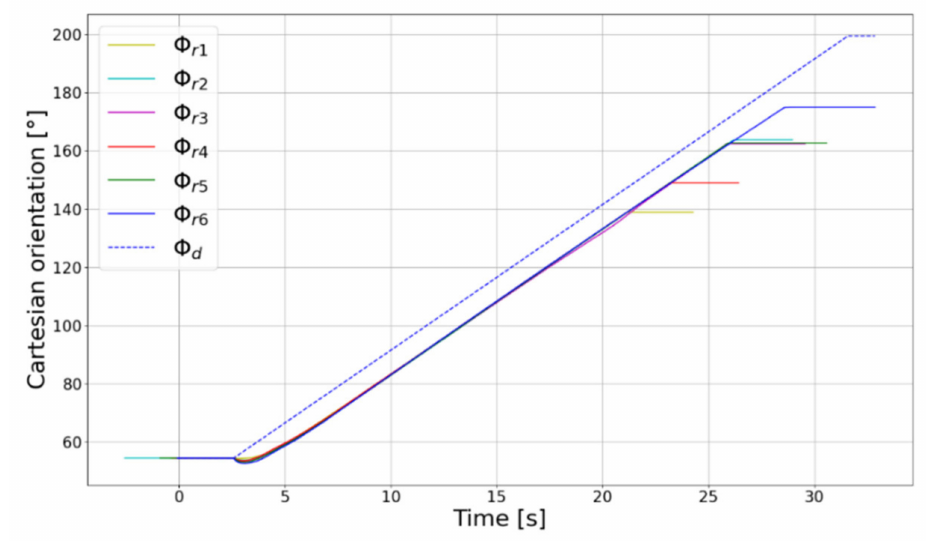
Figure 19. Comparison between the desired probe self-rotation φ d and the executed self-rotation φ r for the different constant weighting matrix choices presented in Table 1. Table 3. Joint parameters applied for the adaptive JLA strategy. The mechanical limits q are provided by the